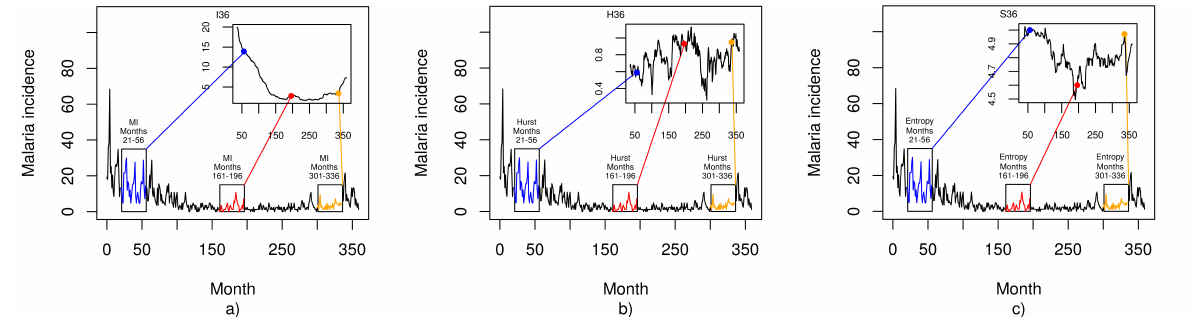
Figure 3. ( a ) Illustration of how a 36-month moving average of malaria incidence, symbolized as I 36 , is obtained from an original series of monthly malaria incidence values, either empirical or simulated. Similar procedures are used to compute ( b ) H 36 and ( c ) S 36 . See text for details. In this case, we